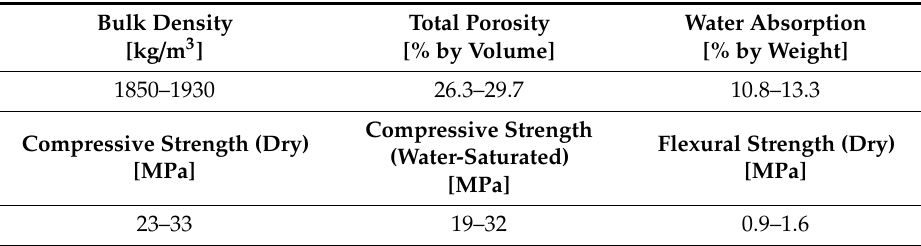
Table 1. The basic physical and mechanical properties of the Mšen é sandstone (adopted from Rybaˇr í k [45,46]).